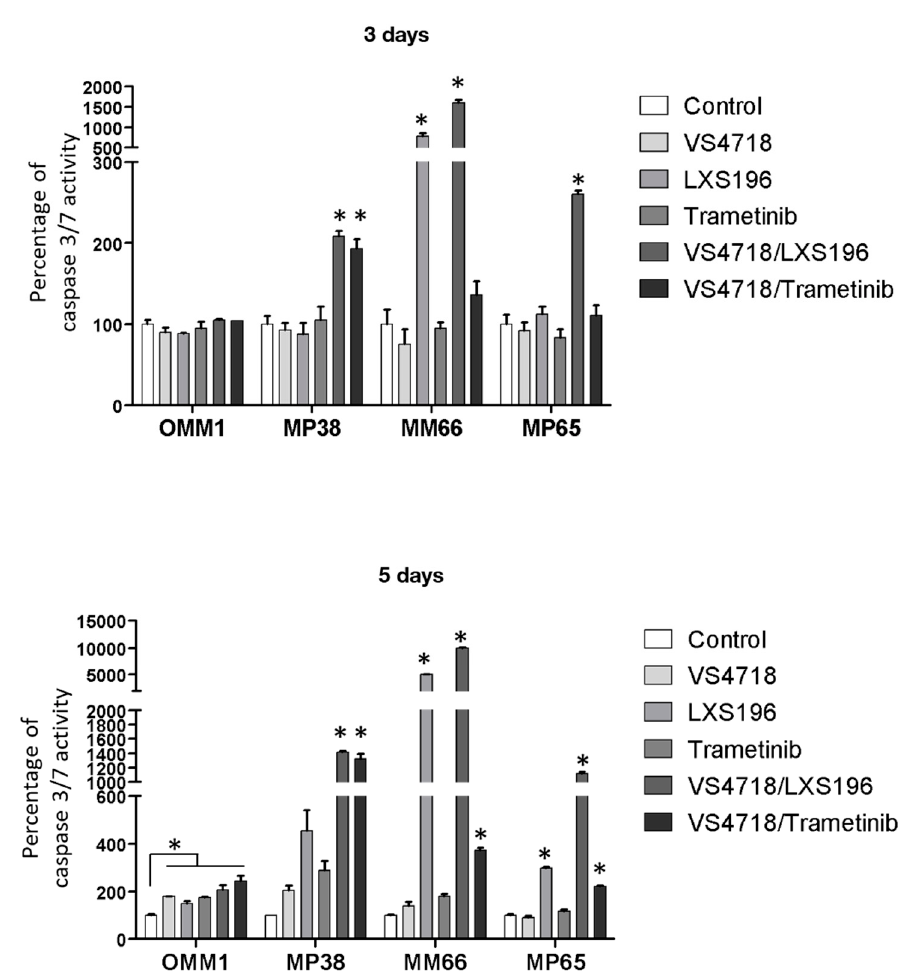
Figure 2. Apoptosis induction in 4 different UM cell lines treated with FAK inhibitor (VS4718) combined with PKC inhibitor (LXS196) or MEK inhibitor (Trametinib). Quantification of apoptosis induction at 3 or 5 days of treatment. A fluorescence-based assay was used to determine the activity of caspase-3 and caspase-7, indicators of apoptosis induction. Data are represented as the mean of triplicates ± SD. Paired t -test was used to generate the p -values comparing each condition to